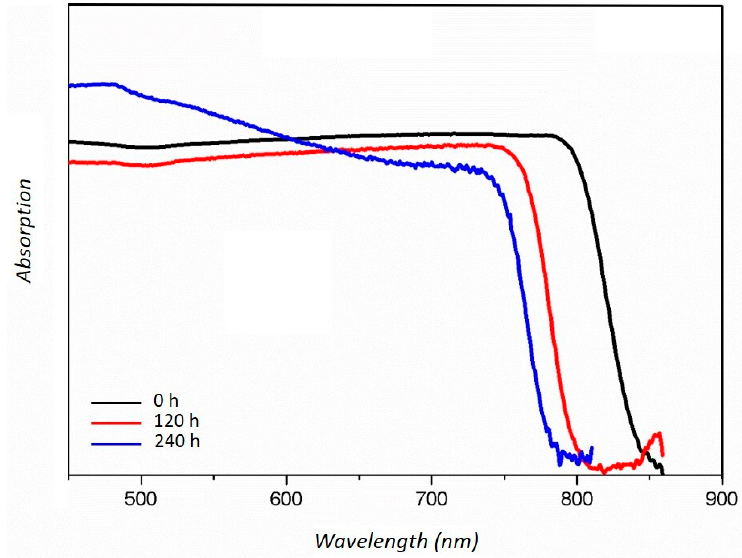
Figure 5. Absorption spectra of as-prepared (0 h) MAPbI 3 , and after 120 and 240 h of ball-milling.